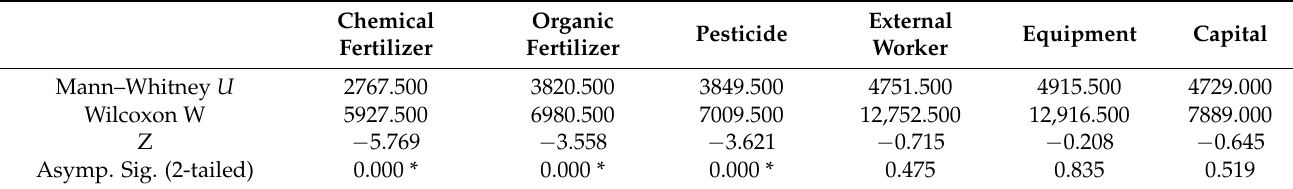
Table 6. Mann–Whitney Analysis for the COVID-19 impact on input